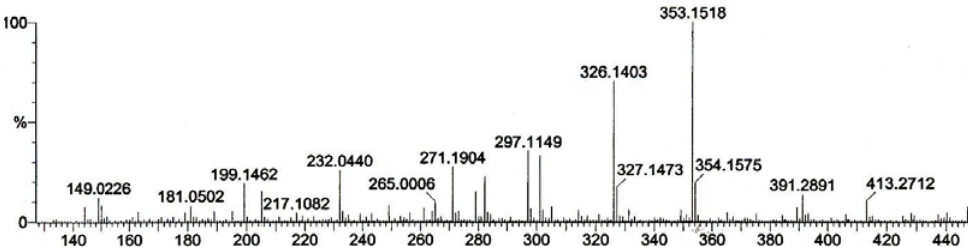
Figure 2. HRFABMS Spectrum of alkaloid 1